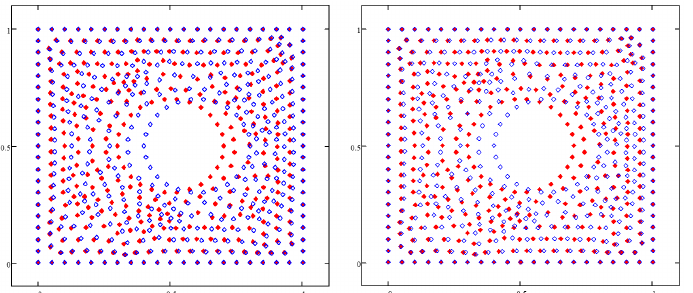
Figure 2. Plate with circular hole. Nodal displacements achieved by means of pseudo-solid ( left ) and RBF ( right ).